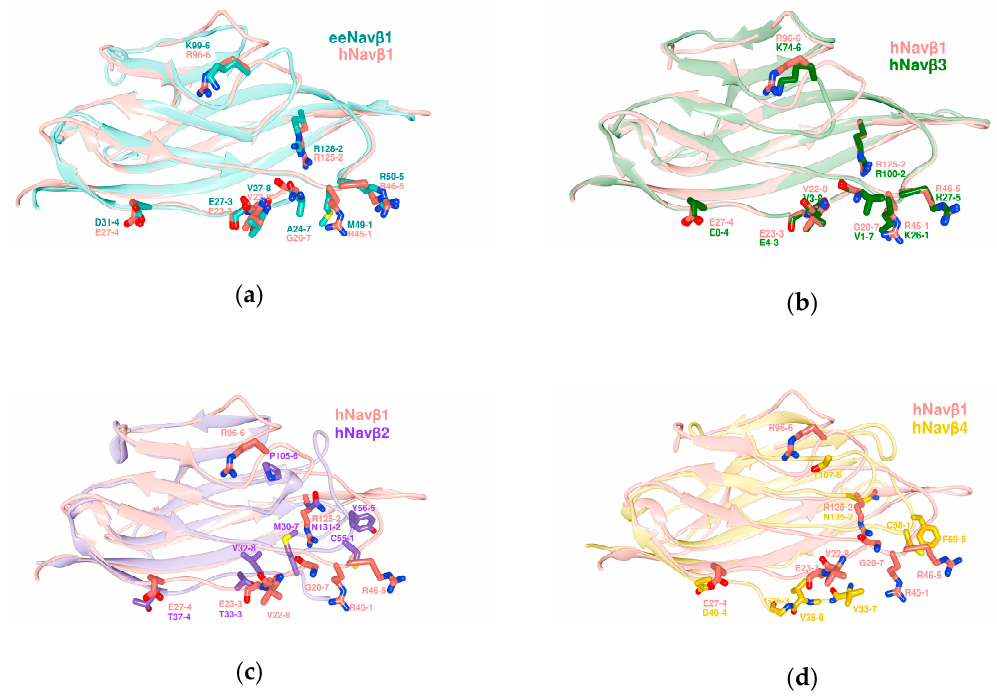
Figure 4. Structure alignments of the ectodomains (IgD) of β subunit templates. ( a ) eeNa v β 1 with hNa v β 1; ( b ) hNa v β 1 with hNa v β 3; ( c ) hNa v β 1 with hNa v β 2; ( d ) hNa v β 1 with hNa v β 4; eeNa v β 1: sea green; hNa v β 1: salmon; hNa v β 3: forest green; hNa v β 2: purple; hNa v β 4: golden; labels 1 to 8: positions of MSA residues according to Table 2. All superpositions were achieved by Chimera Alpha 1.14 with MatchMaker [61].